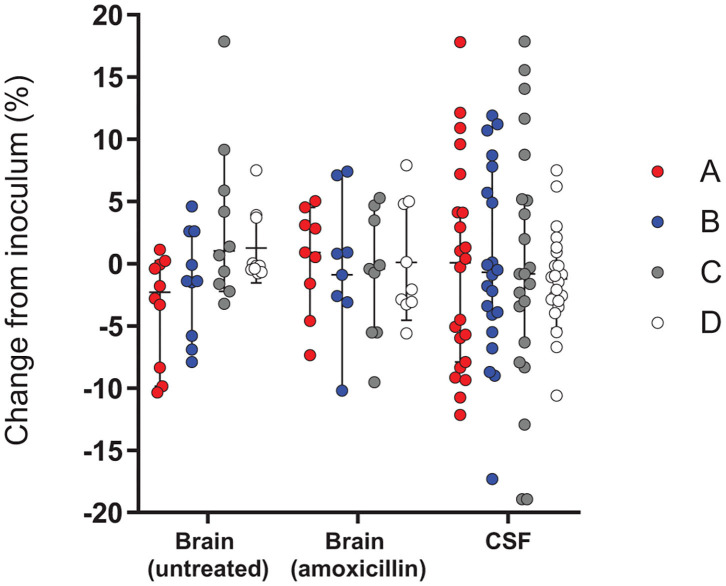
Change in frequency of the expressed RMS allele between the inoculum and different in vivo samples in infection with a mixture of the 4 RMS allele variants. The relative proportions of hsdS variants A (red), B (blue), C (gray) and D (white) between the inoculum and the bacteria harvested in the different in vivo samples, including the brains of untreated animals (n = 10) or AMX-treated animals (n = 9) and CSF samples (n = 22), were not significantly different between the alleles. A Kruskal-Wallis test found no significant differences between variant proportions in the inoculums and in vivo samples.